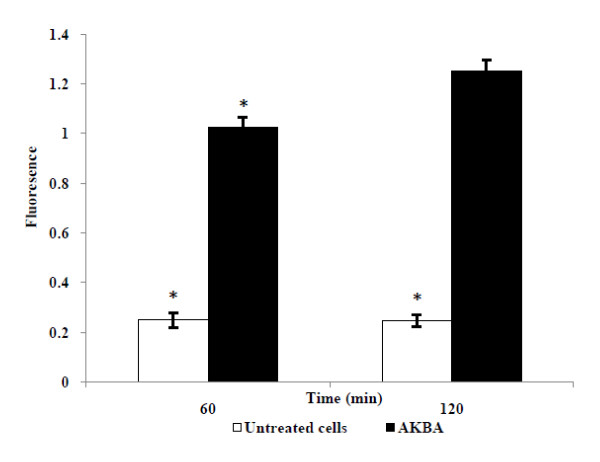
Uptake of propidium iodide in cell of S. aureus ATCC 29213. Cells of S. aureus were treated with AKBA at 64 μg/ml for 60 and 120 min. Control group included cells untreated with AKBA. AKBA treated cells significantly increases the fluorescence compared with untreated control (P < 0.05). Data represent the mean and standard deviations (±SD) of two different experiments performed in triplicate. *, P < 0.05 (Student's t test).